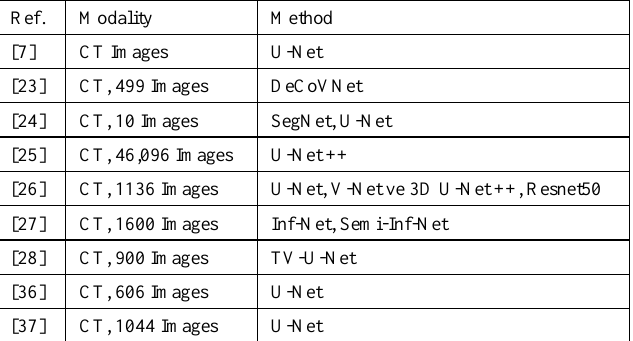
COVID-19 S EGMENTATION L ITERATURE S